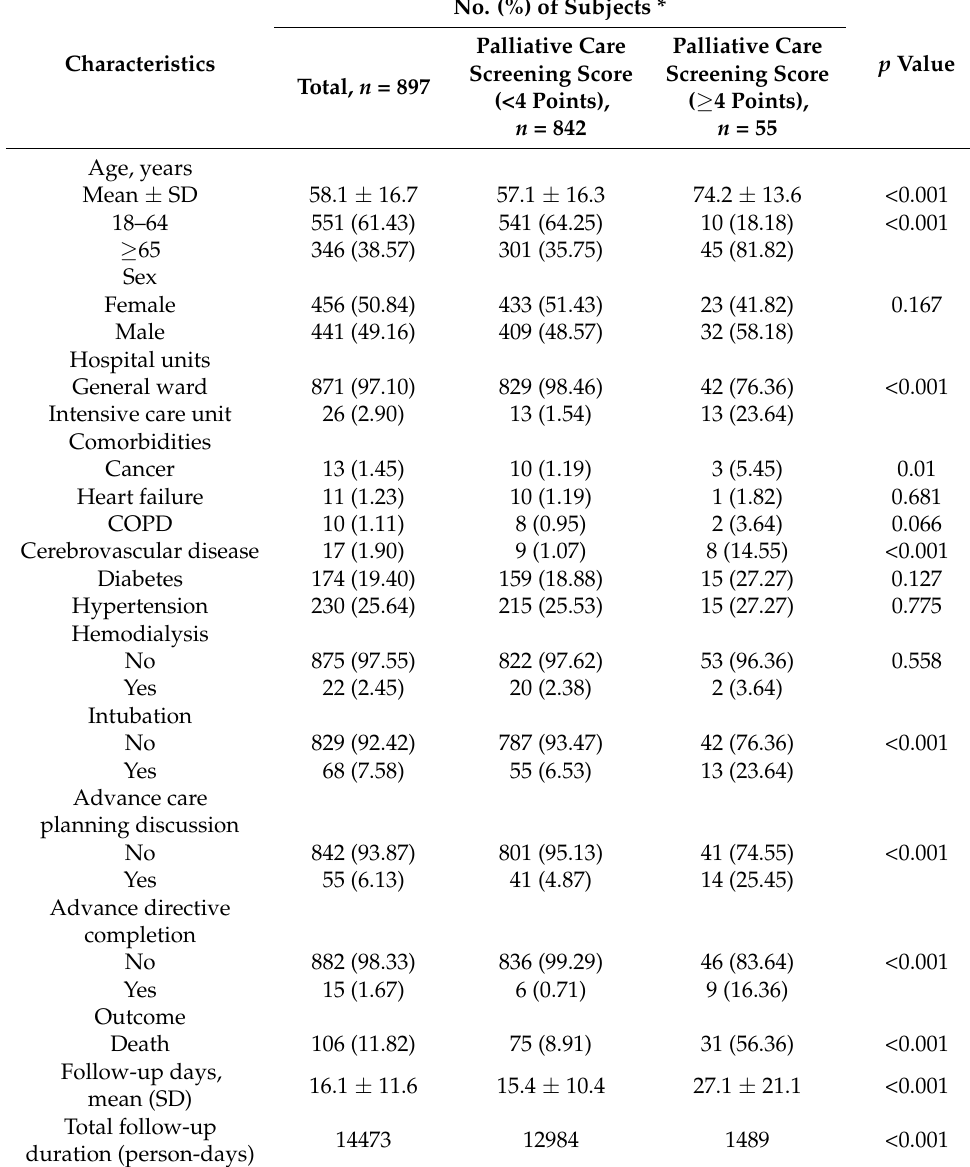
Table 1. Baseline characteristics of the study participants based on palliative care screening tool score.